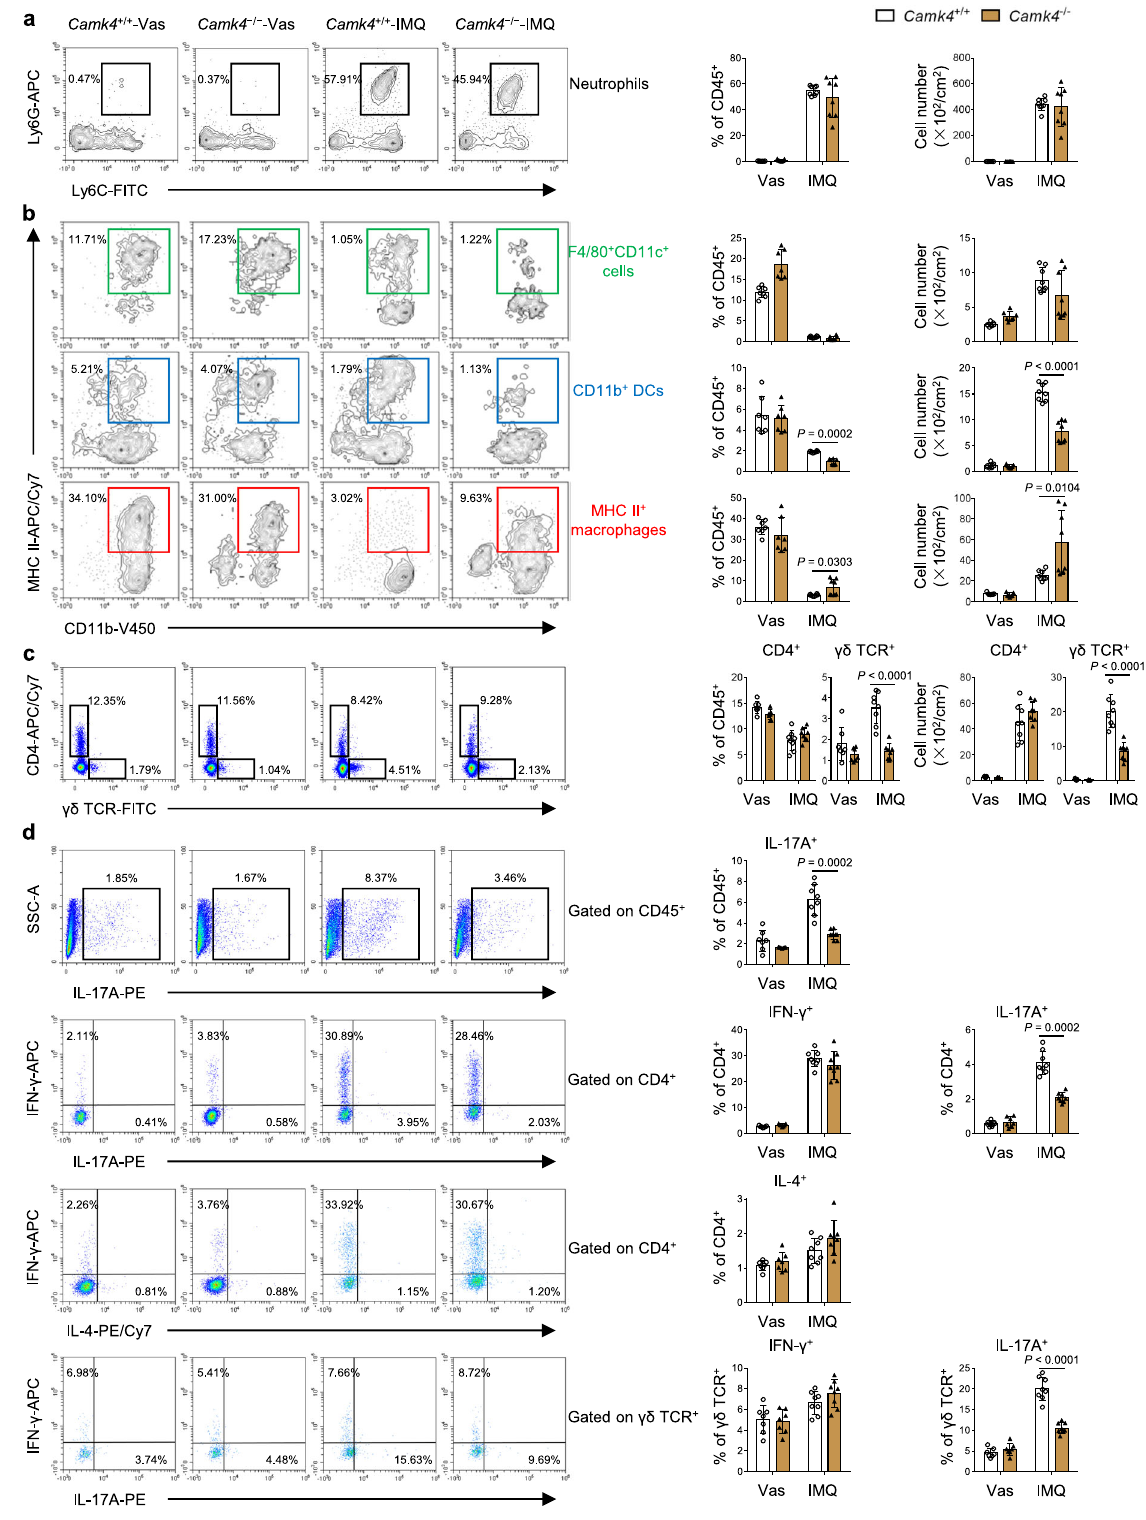
Fig. 3 | Analysis ofmouseskinmyeloid celland T-cell subsets. a Representative fl owcytometryplotsandstatisticalanalysisofneutrophils. b Representative fl ow cytometry plots and statistical analysis of F4/80 + CD11c + cells, CD11b + DCs, and MHC II + macrophages. c Representative fl ow cytometry plots and statistical analysis of CD4 + and γδ TCR + cells. a – c Representativepercentages indicate each subsetasaproportionoftotalCD45 + cells. d Representative fl owcytometryplots